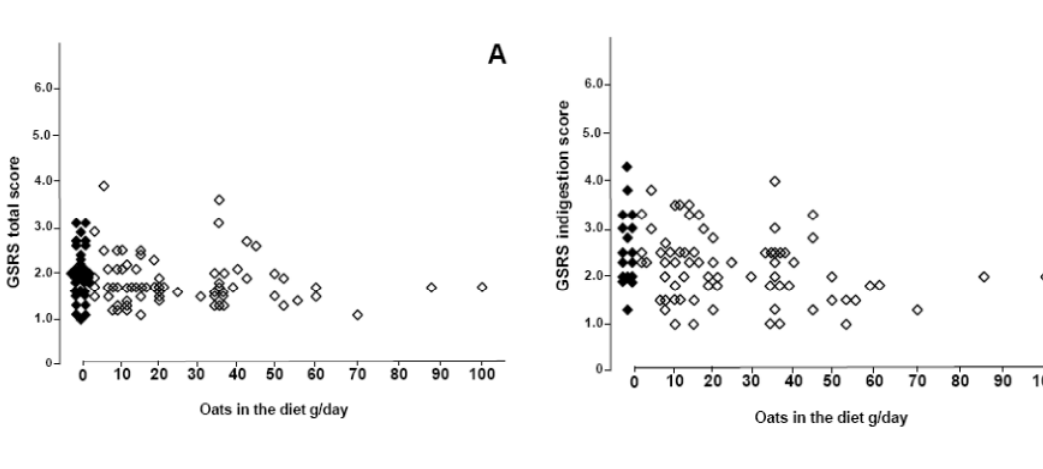
25.5 kg/m 2 , range 19.2–33.0 kg/m 2 vs. 26.6 kg/m 2 , range 19.0–34.6 kg/m 2 p = 0.671). All treated celiac patients were negative for serum EmA- and tTG-abs (median 0.5 U/L, range 0–2.9 U/L). Blood hemoglobin levels did not correlate with the consumption of oats (data not shown). Figure 2. Gastrointestinal symptom rating scale (GSRS) total score correlated negatively with daily oat intake in 106 treated celiac disease patients ( A ) r = − 0.220, p = 0.025, but not with the duration of oat consumption ( r = − 0.166, p = 0.101 [data not shown]). A high daily oat intake and a long duration of oat intake correlated with less indigestion ( B ) r = − 0.313, p = 0.003 and r = − 0.232, p = 0.037 [data not shown], respectively. Black diamond = no oats. Open diamond = oat